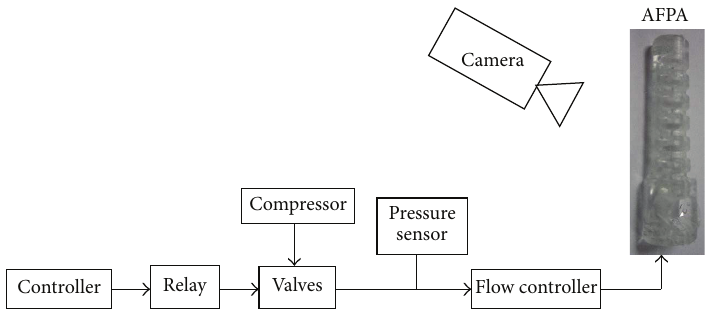
Figure 10: Block diagram of experimental setup for the control of AFPA.